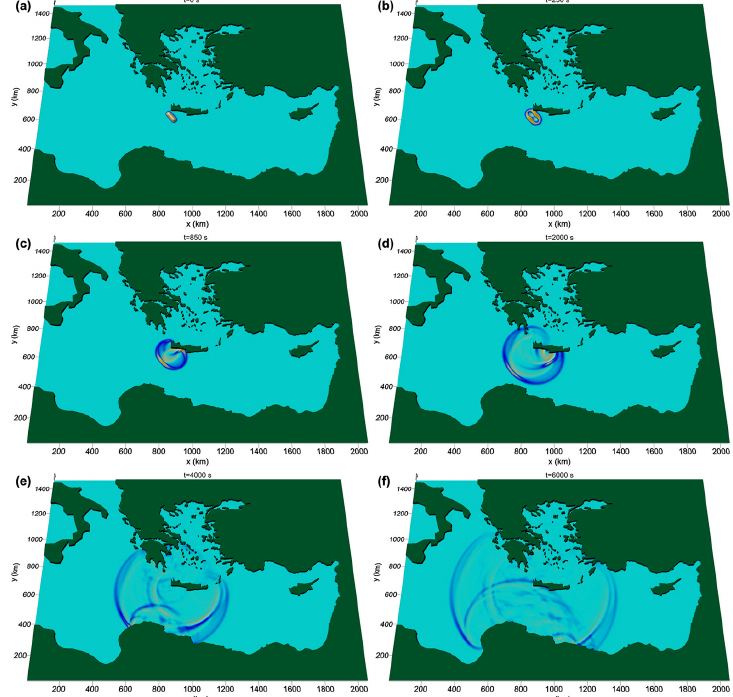
Figure 8. Sequences of snapshots of water elevation for the earthquake-induced tsunami scenario at the southwest of Crete at: (a) t = 0s